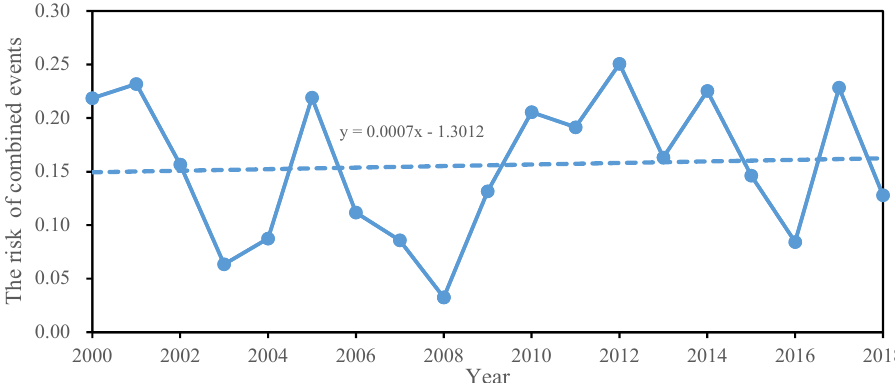
Figure 8. Temporal variation in the combined-events risk of drought and high-temperature heat waves on the North China Plain in summer from 2000 to 2018.